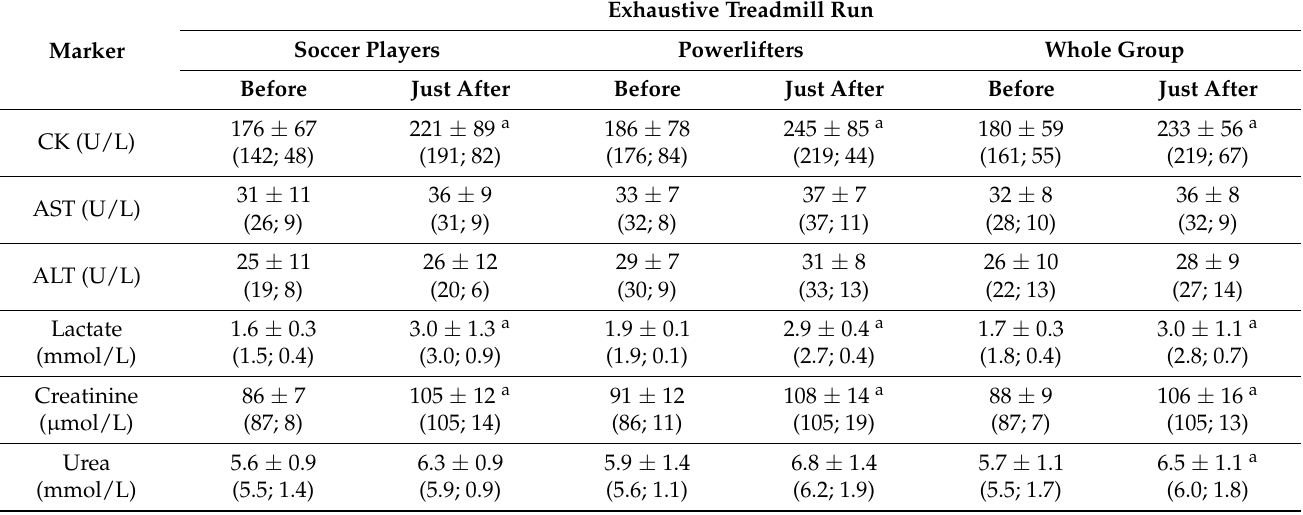
Table 4. Selected markers of muscle damage and metabolic response to exercise before and after exhaustive treadmill run.